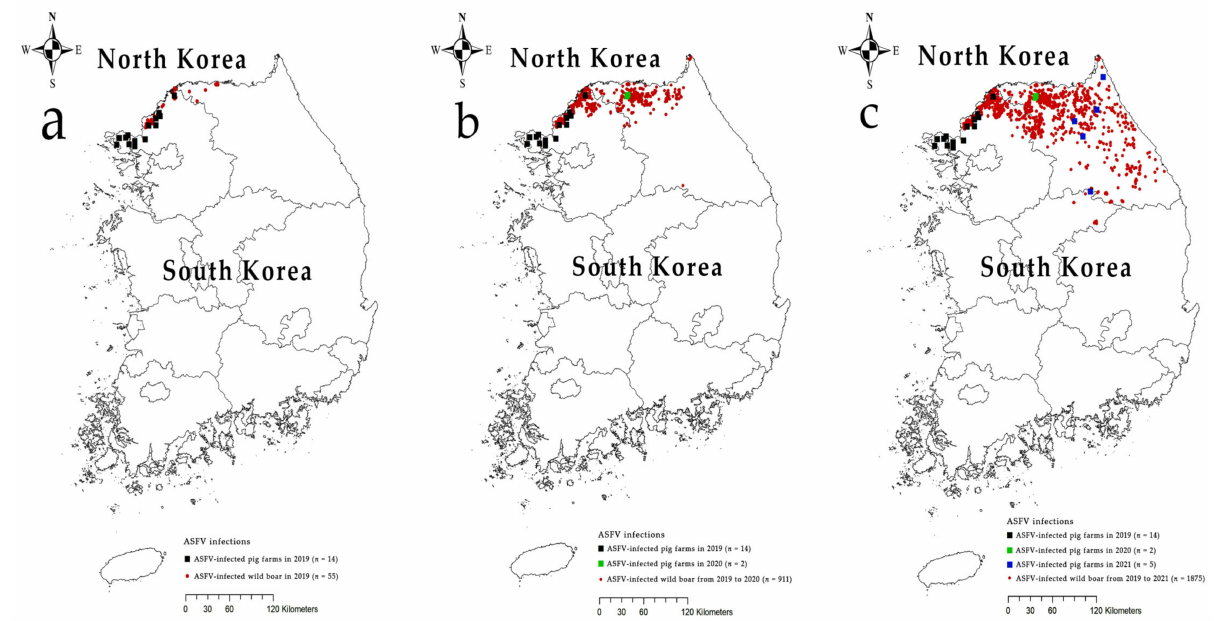
Figure 1. ASF outbreaks in domestic pig farms in South Korea during 2019–2021: ( a ) until blue rectangles indicate ASFV-infected pig farms in 2019, 2020, and 2021, respectively. Red circles are the location where ASFV-infected wild boars were